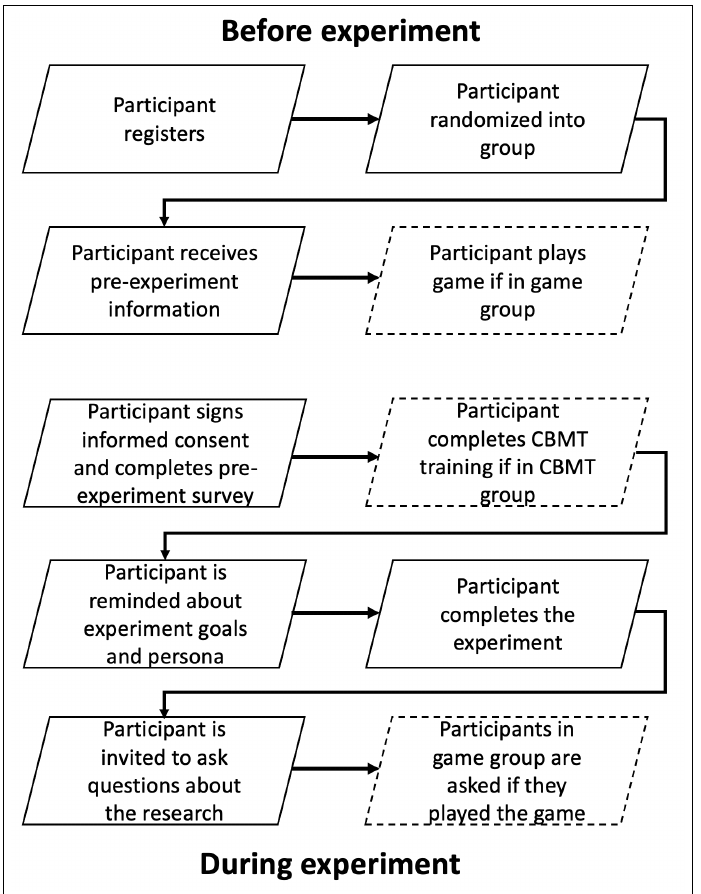
Figure 4. Visualization of experiment procedure. Dashed boxes only applied to some